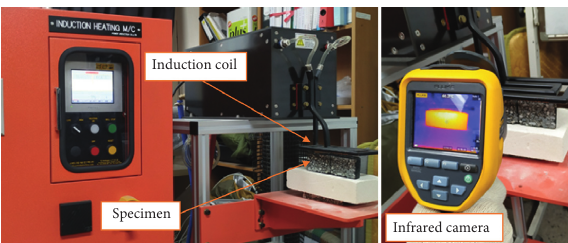
Figure 3: Induction healing test setup.